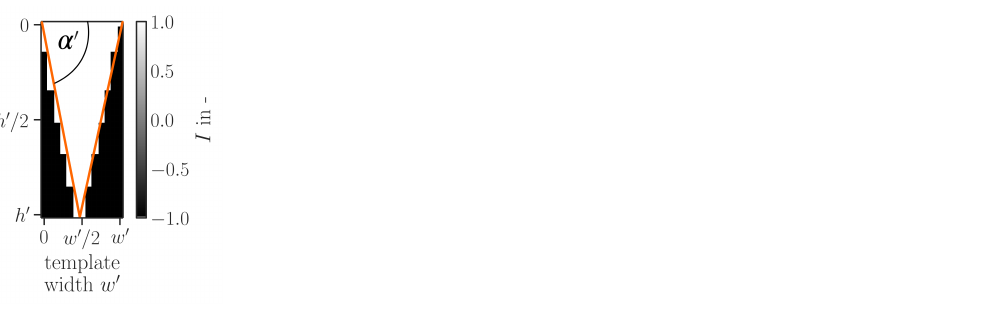
Figure 3. Example of a turbulence wedge template with height h (cid:48) , width w (cid:48) and angle α (cid:48) , which determines the position of the